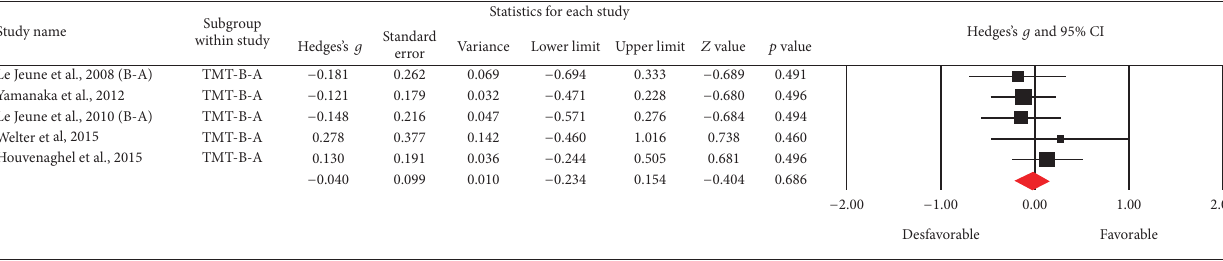
Figure 11: Meta-analysis of TMT-AB comparing before and after DBS